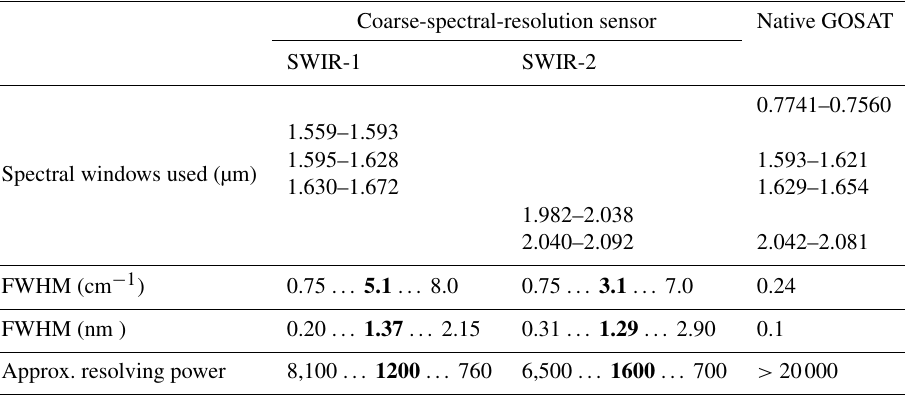
Figure 2. Measured GOSAT spectrum of the backscattered radiance in the NIR, SWIR-1 and SWIR-2 (a–c) ranges shown in grey with respective GOSAT retrieval windows in bold black. The spectrally degraded measurements at resolving powers of ∼ 1200 (SWIR-1) and ∼ 1600 (SWIR-2) are shown in bold blue and bold red, respectively. Table 1. Spectral windows for the various retrieval configurations. Bold numbers indicate the spectral resolution that was chosen for subse- quent analyses (see Sect.